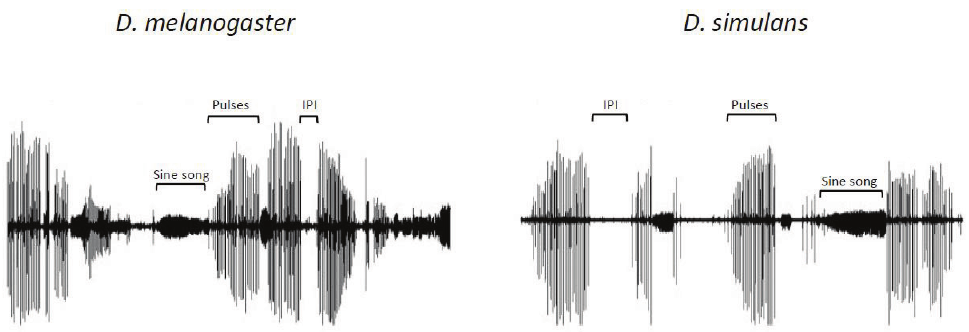
Figure 2. Courtship song of Drosophila melanogaster and Drosophila simulans males recorded for 10 s. The original figure (from [23]) has been modified for this